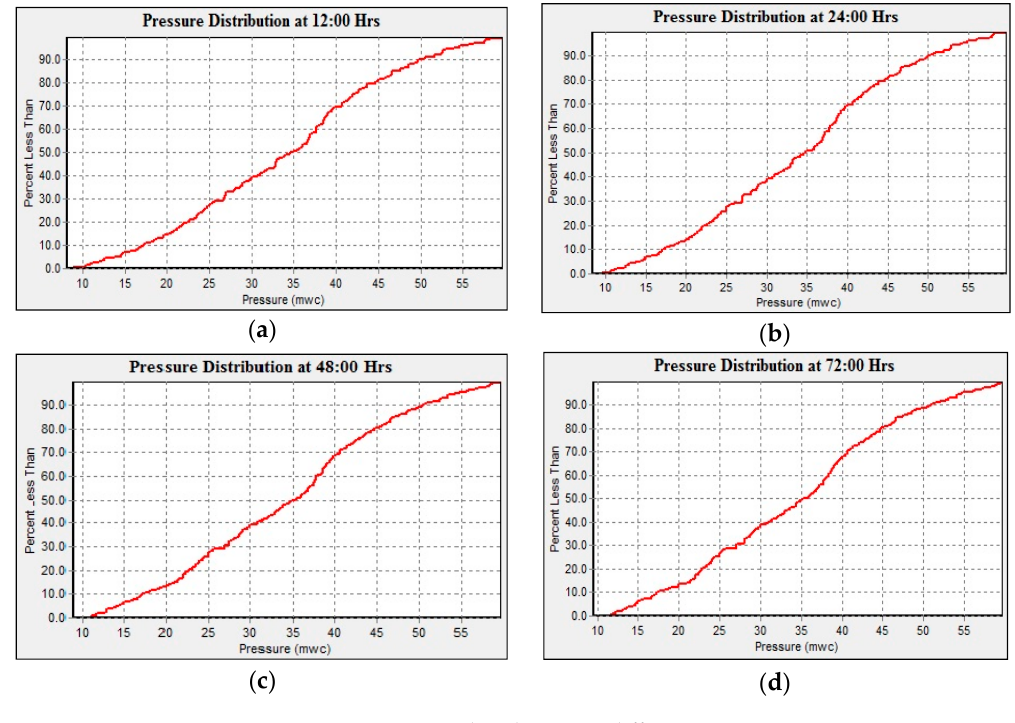
Figure 10. Pressure distribution at different times.